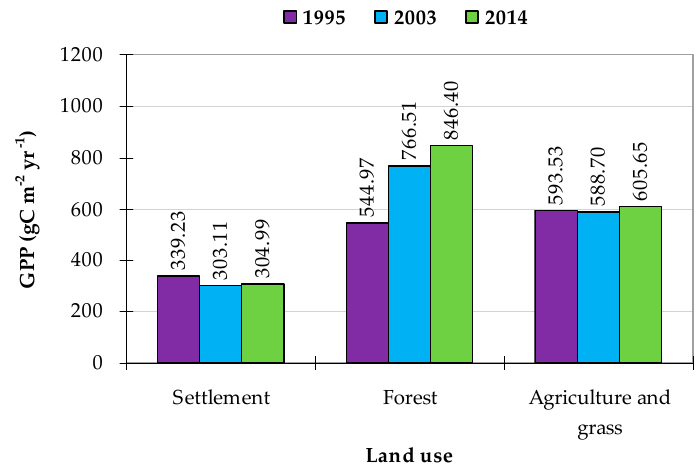
Figure 5. Mean of annual GPP in Denpasar from Landsat satellite data analysis of each land use type. Table 5. GPP estimation changes in each type of land use in Denpasar from 1995 to 2014.